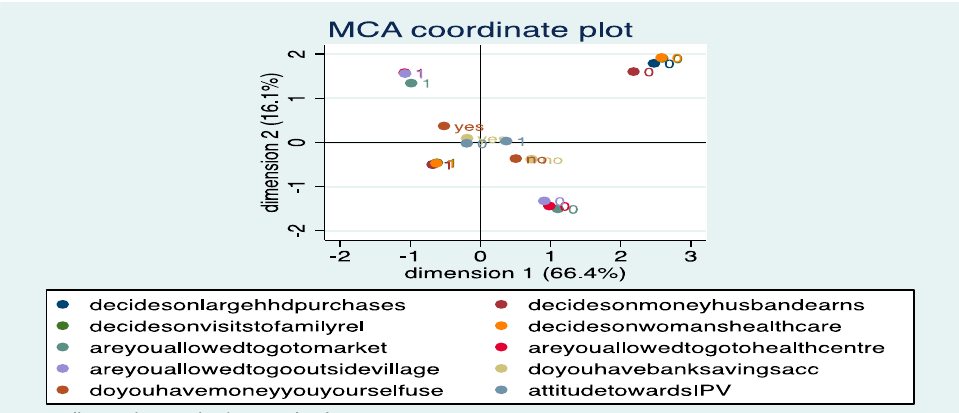
Figure 3. MCA coordinate plot in standard normalisation. Source: Authors’ calculations.